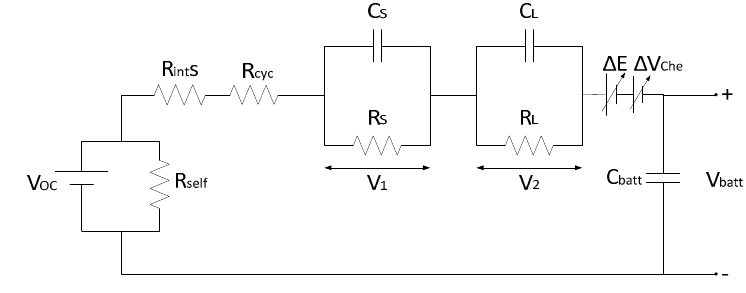
Figure 4. Wijewardana battery circuit model.